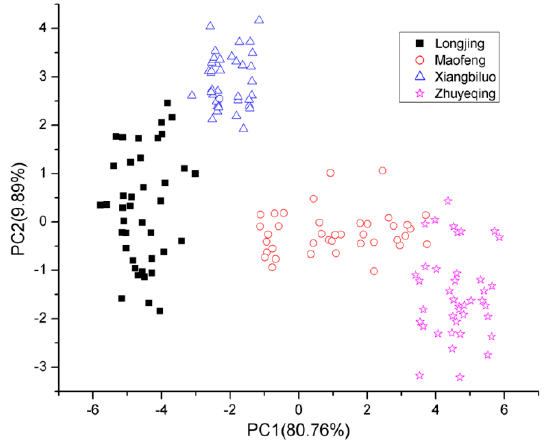
Figure 5. Scattered scores plot PC1, PC2.